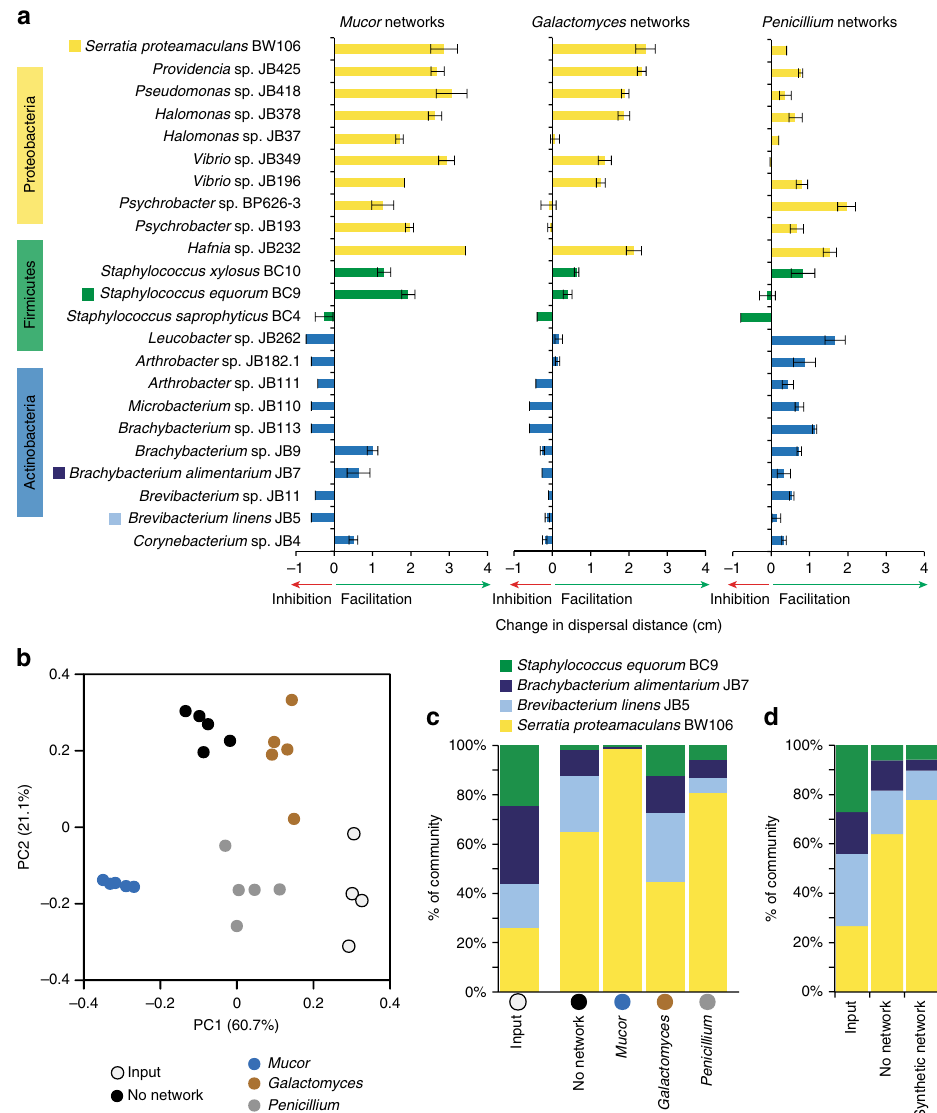
Fig. 4 Fungal networks facilitate the dispersal of Proteobacteria and shape the diversity of cheese rind communities. a Dispersal of various cheese rind bacteria on fungal networks. Data show change in dispersal distance (as measured from the center of the bacterial colony to the edge) on Mucor , Galactomyces , or Penicillium networks compared to growth alone after 14 days of growth. Dispersal assays were conducted on BHI agar. Bars are mean ± 1 standard deviation ( n = 3). Taxa indicated with a colored box were used in community experiments. b Principal coordinates analysis of relative abundance data from experimental communities on cheese curd agar with different fungal networks. “ Input ” indicates the input inoculum used to set up the experiment. The “ No network ” treatment included no fungus. Mucor , Galactomyces , and Penicillium treatments included living fungal networks of the respective fungi. Each community treatment was replicated fi ve times. The addition of fungal networks shifted the composition of the bacterial communities compared to no network communities (PERMANOVA F = 72.14, p < 0.001). c Mean relative abundance (% of total CFUs) of bacteria within the experimental communities with different fungal networks after 14 days of growth. Treatments are the same as in b . d Mean relative abundance (% of total CFUs) of bacteria in control communities ("No network") and communities with a glass fi ber network ("Synthetic network") after 14 days of growth. Synthetic networks shifted bacterial community composition compared to the no network controls (PERMANOVA F = 7.38, p <